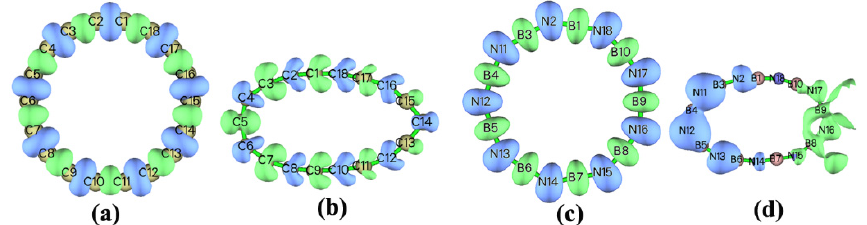
Figure 8. Comparison of the reactivity sites predicted by the double descriptors for cyclo[18]carbon and B 9 N 9 at the same EEF at different EEF intensities; ( a , b ) for cyclo[18]carbon, corresponding to an EEF of 0.029 a.u. and ( c , d ) for B 9 N 9 , corresponding to an EEF of 0.029 a.u., respectively.